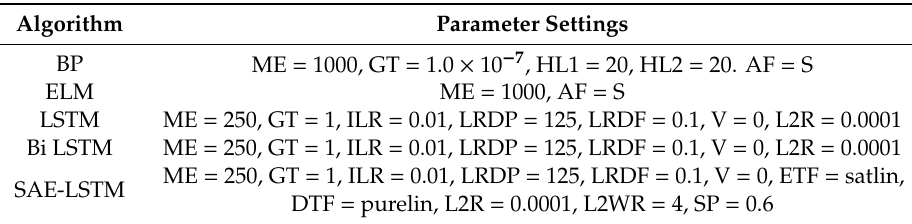
Table 6. Parameter setting of the neural